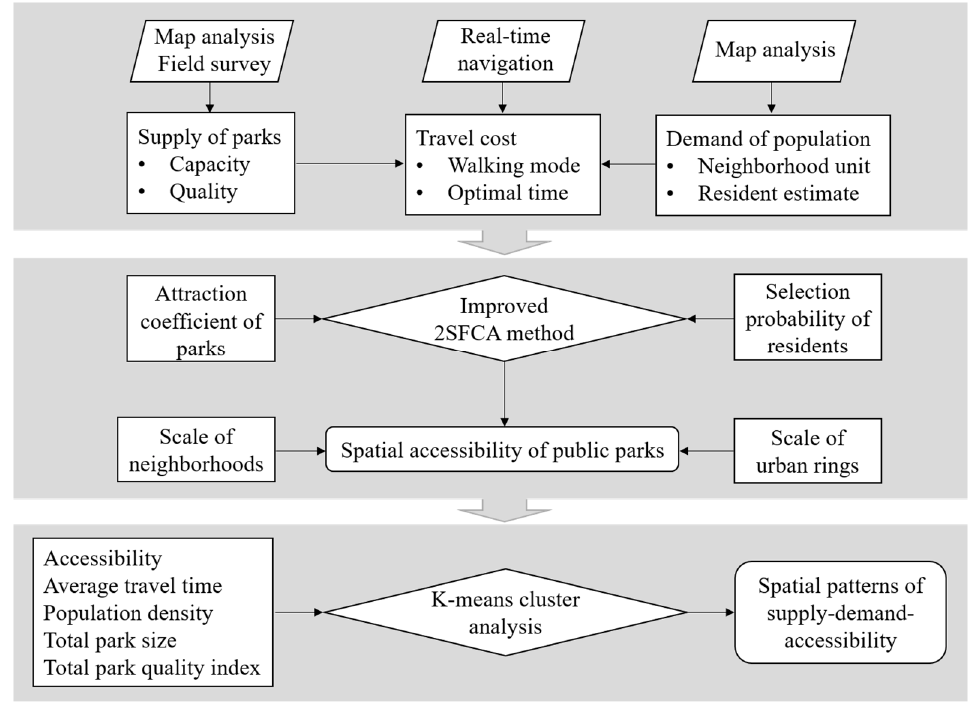
Figure 1. Research framework for accessibility analysis and equity evaluation of urban parks.